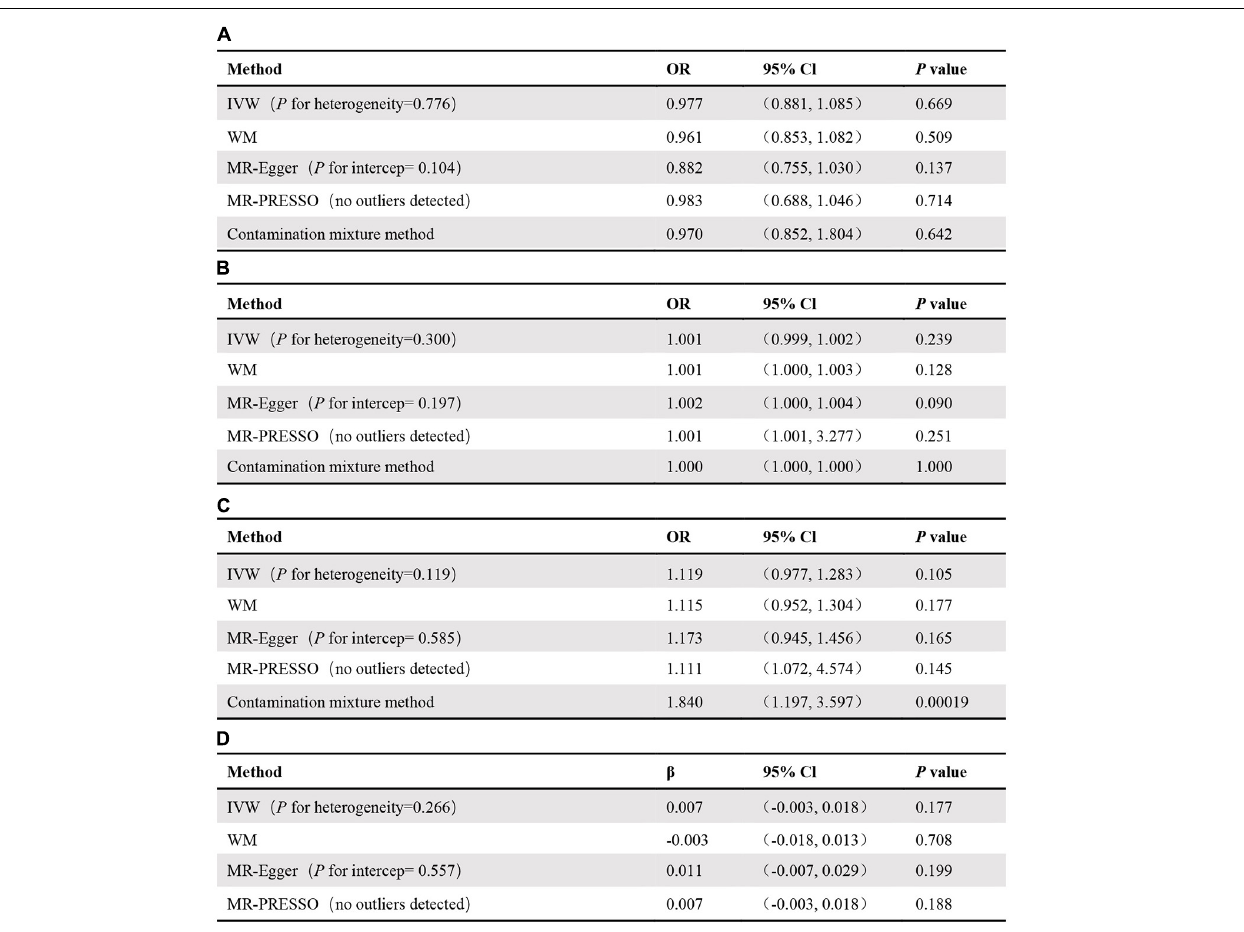
FIGURE 2 | MR results for association of adiponectin and original-RA (A) , the UK Biobank-RA (B) , the FinnGen consortium-RA (C) , as well as association of RA and adiponectin (D)